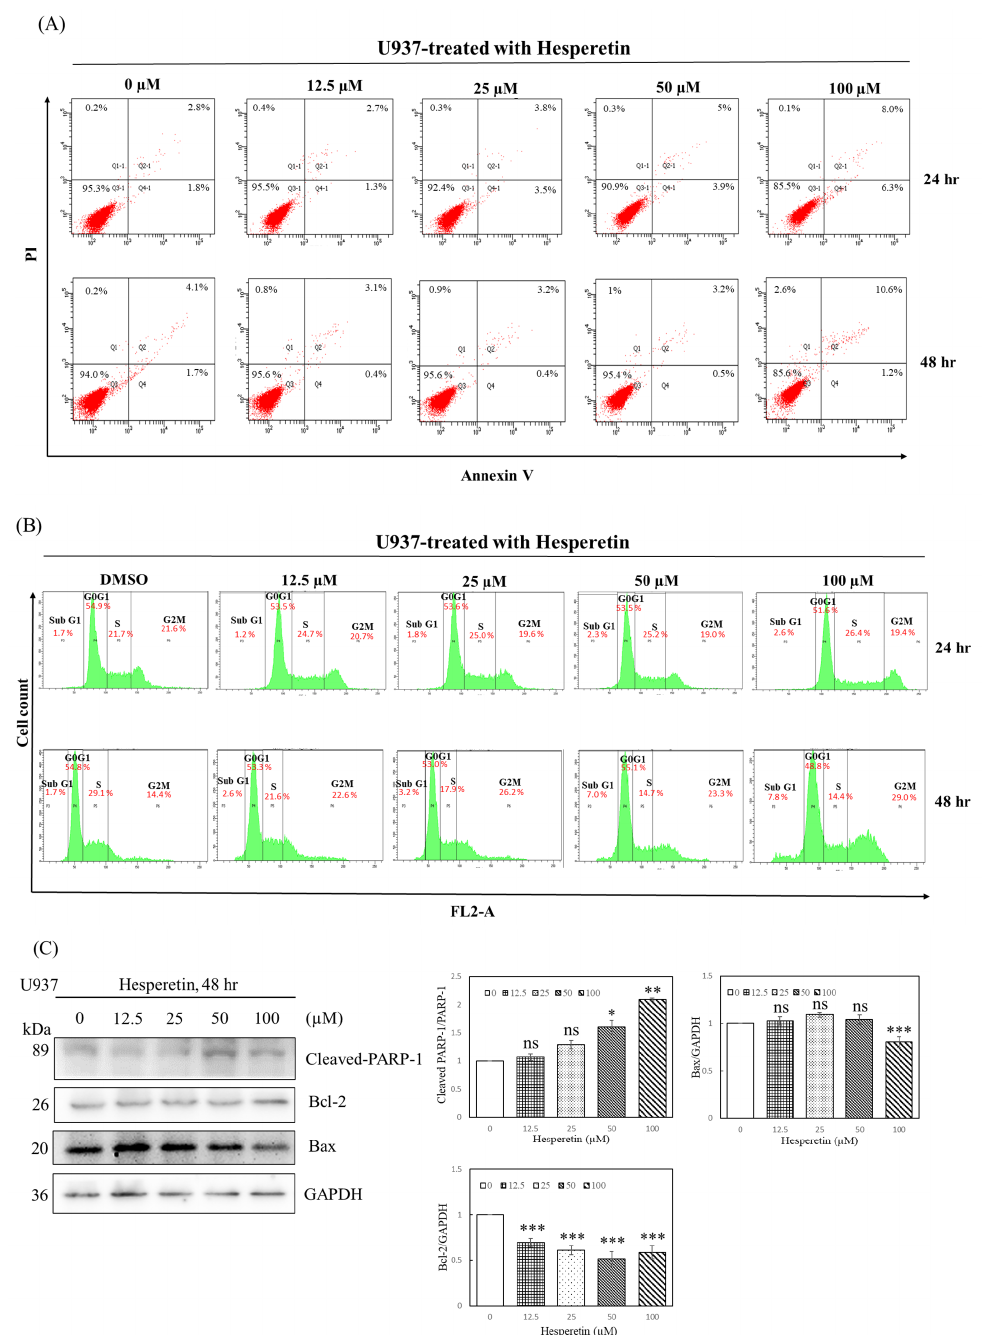
Figure 2. Effects of hesperetin compounds on apoptosis and cell cycle arrest of U937 cells. ( A ) U937 cell apoptosis was analyzed at 24 and 48 h by flow cytometry with annexin V-FITC/PI staining to distinguish early apoptotic (annexin V-FITC positive, PI negative; Q4-1 and Q4) from late apoptotic or necrotic cells (Annexin V-FITC positive, PI positive; Q2-1 and Q2). ( B ) The cell cycle was assessed using flow cytometry in U937 cells with or without hesperetin treatment. ( C ) U937 cells were treated with hesperetin at 0, 12.5, 25, 50, and 100 µM for 48 h. Cleaved-PARP-1, Bcl-2, Bax, and GAPDH expressions were analyzed with Western blotting by using the cell lysates. The mean ± SD of the three independent experiments performed in triplicate are shown. * p < 0.05; ** p < 0.01; *** p < 0.001 vs. the control group; ns, not significant; the results are representative of three independent experi- ments.